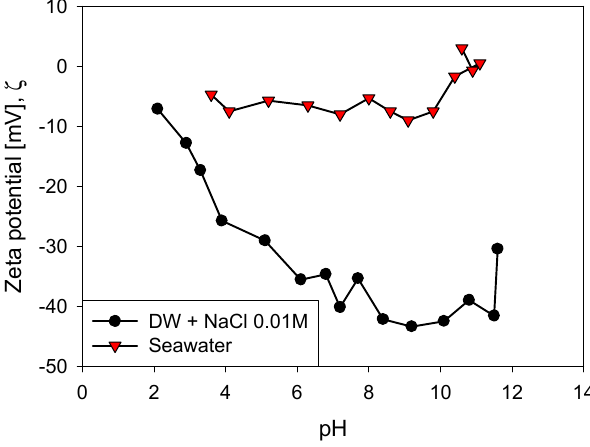
Figure 6. Zeta potential for kaolin particles in seawater and distilled water with sodium chloride 0.01 M.